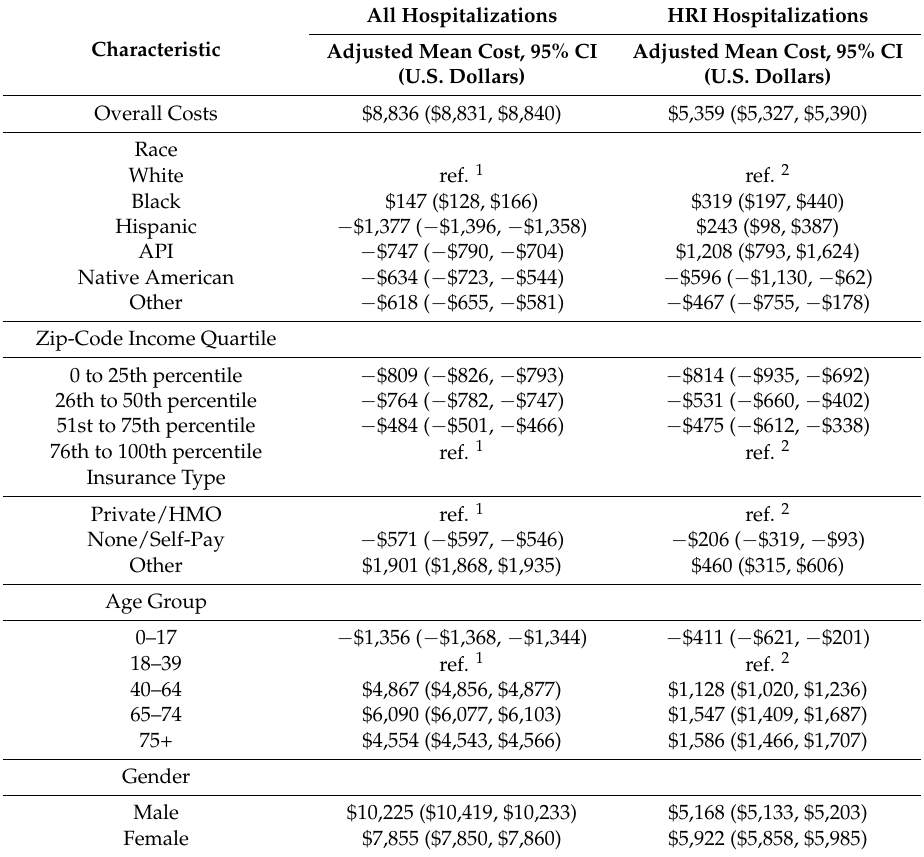
Table 3. Comparisons of nationally adjusted mean costs per hospitalization by race, zip-code income quartile, insurance type, age 65 and older, and gender, 2001–2010